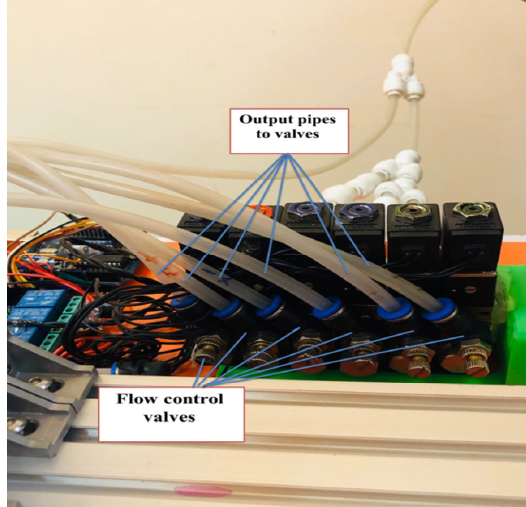
Fig. 8. Circuit of control system I/O.